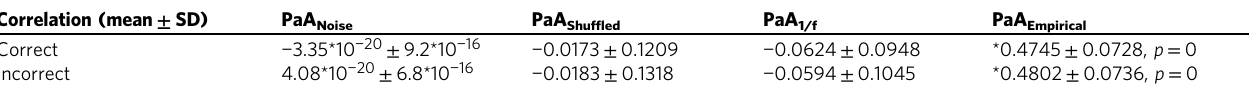
Table 3 Correlations are speci fi c to the alpha bump Correlation (mean ± SD)